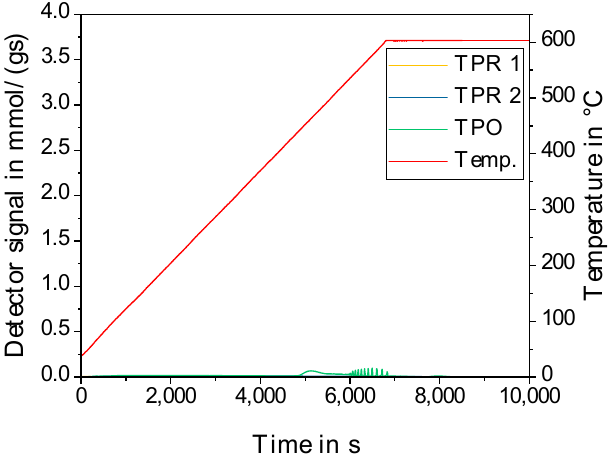
Figure A1. Results of TPROR measurements of the silica carrier material Aerosil380, 40 °C to 600 °C; total hydrogen consumption of 0.08 mmol(H 2 )/g.